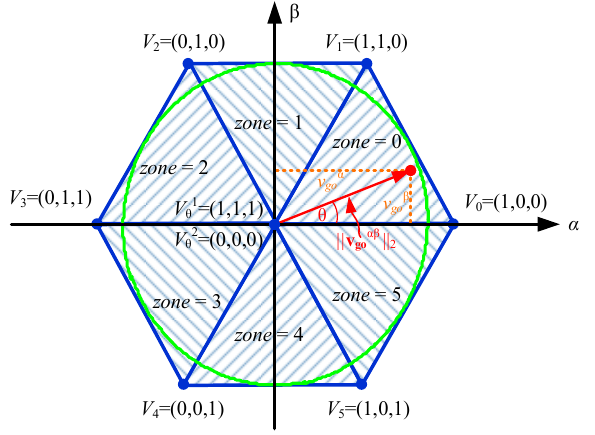
Figure 2. Space vector states.